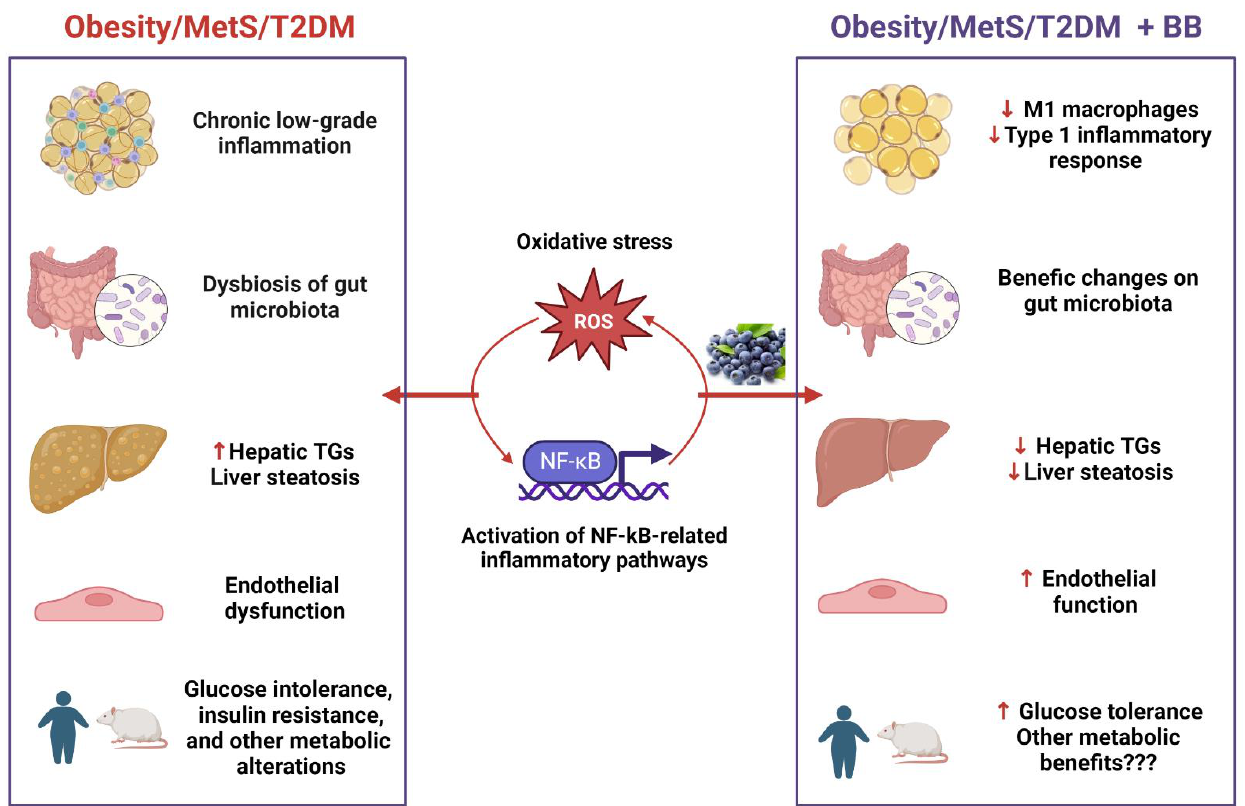
Figure 2. The effects of blueberries (BB) and bilberries in outcomes related to obesity, metabolic syndrome (MetS), and type 2 diabetes mellitus (T2DM). Obesity and associated metabolic disorders are characterized by systemic and chronic low-grade inflammation, dysbiosis of the gut microbiota, and other metabolic alterations, including increased triglycerides (TGs) content in the liver, liver steatosis, glucose intolerance, insulin resistance, and endothelial dysfunction. The main mechanisms behind these alterations are the increased oxidative stress and activation of the nuclear factor- κ B (NF- κ B)-related pro-inflammatory pathways. Anthocyanins and other components of blueberries and bilberries are able to decrease the production of reactive oxygen species (ROS) and the activation of the transcription factor NF- κ B, thus decreasing the expression of its pro-inflammatory target genes. The attenuation of these two key mechanisms may lead to: (1) decreased recruitment of pro-inflammatory M1 macrophages into the adipose tissue and type 1 inflammatory response (T helper cells); (2) benefic changes on the composition of gut microbiota, further decreasing NF- κ B activation; (3) decreased TG content in the liver and protection against hepatic steatosis; (4) improvement of endothelial function; and (5) improvement of glucose tolerance. Other beneficial effects of BB consumption still need to be confirmed by well-designed clinical studies. ↓ Reduction; ↑ Increase. This figure was created using BioRender.com (accessed on 1 December